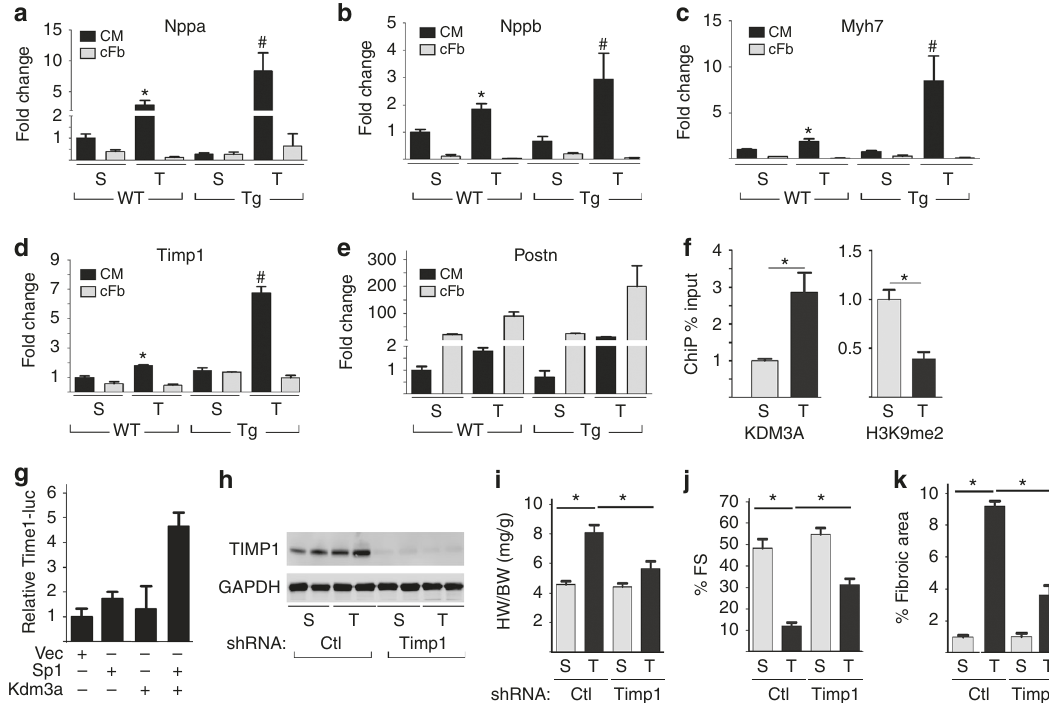
Fig. 5 KDM3A activates the transcription of Timp1 in cardiomyocytes. Cardiomyocytes (CM) and cardiac fi broblasts (cFb) were isolated from WT and Kdm3a-Tg mouse hearts at week 6 post-Sham and TAC surgery. a – e Transcripts of fetal genes and fi brosis-related ECM genes were measured by qRT- PCR, normalized against internal Gapdh, and expressed relative to WT Sham CM. n = 3 ± SEM , * , # p < 0.05 by student t test. *, WT TAC vs WT Sham. # , Tg-TAC vs WT-TAC. f Cardiomyocytes from Kdm3a -Tg mouse hearts at week 6 post-Sham and TAC surgery were isolated and used for ChIP assay with antibodies against KDM3A (left panel) or H3K9me2 (right panel). The relative occupancies of KDM3A and H3K9me2 at Timp1 promoter were normalized against Input and expressed relative to Sham control. n = 3 ± SEM , *p < 0.05 ( t test). g Timp1-Luciferase reporter was transfected in combination with plasmids as indicate into 293 T cells. Cells were harvested 48 h after transfection. Luciferase activities were normalized against co-transfected β - galactosidase, expressed relative to vector-transfected cells. n = 3 ± SEM. (h-k) Kdm3a- Tg mice were transduced with adenovirus AAV9 expressing control or Timp1 shRNA and subjected to Sham or TAC surgery. Hearts were echoed and harvested 5 weeks post-surgery. h WB of TIMP1 and GAPDH, i